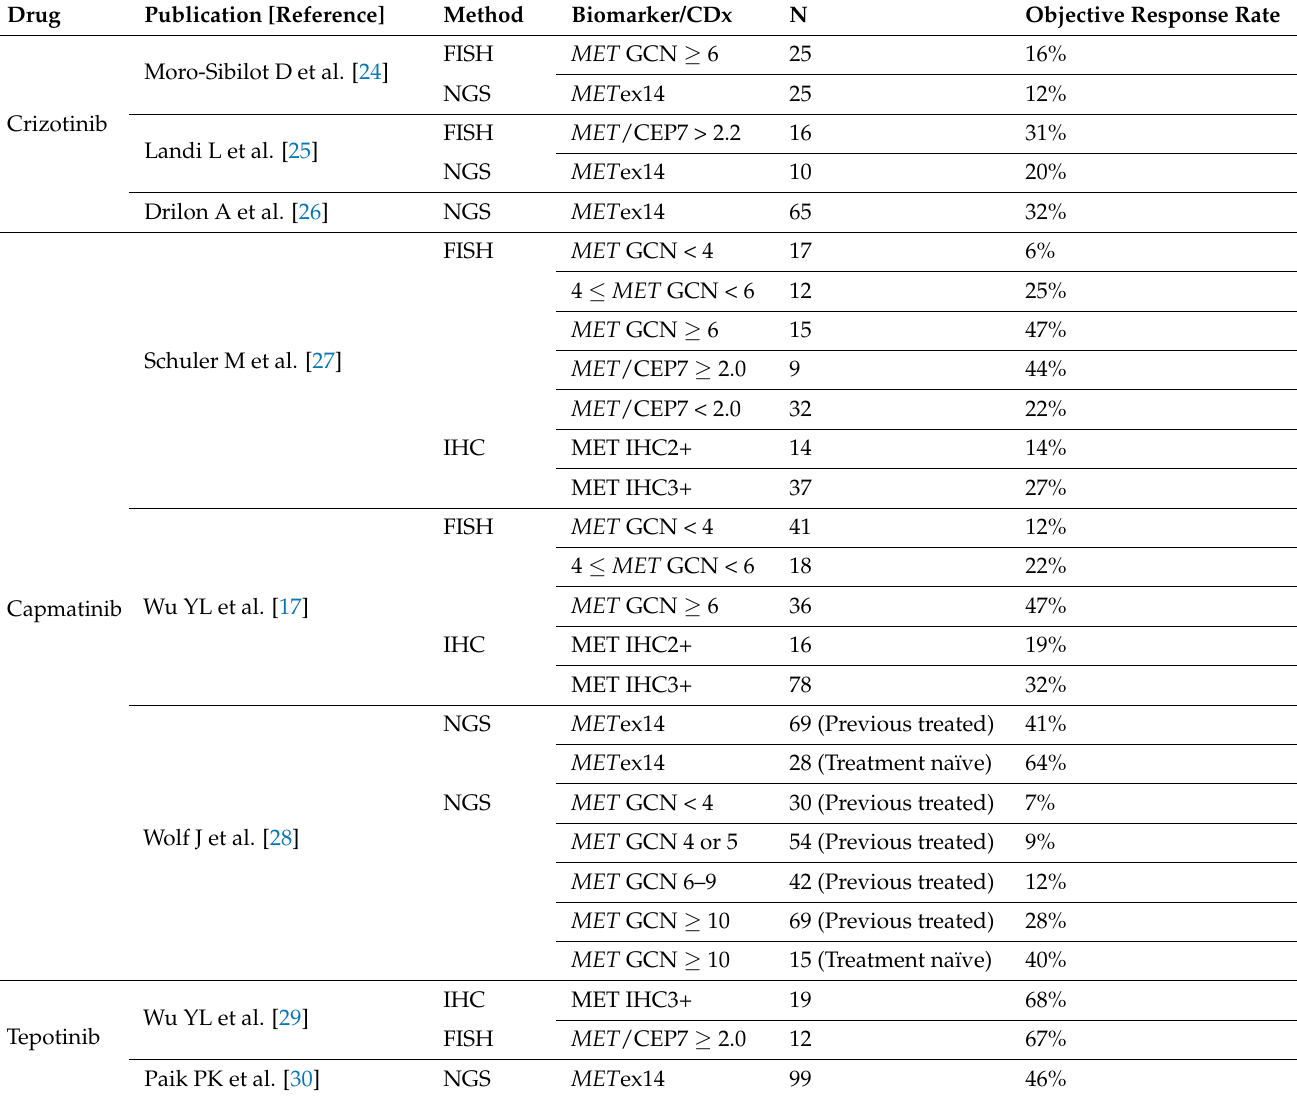
Table 2. Predictive Biomarkers and Companion Diagnostics for the FDA-approved MET Targeted Drugs in